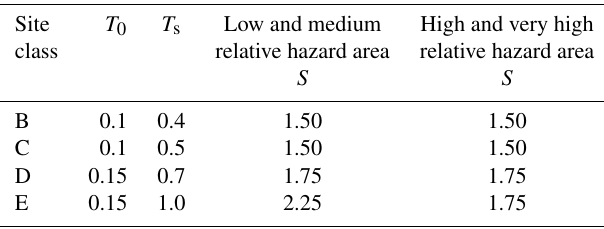
Table A2. Values of T 0 , T s , and S parameters (BHRC, 2015).